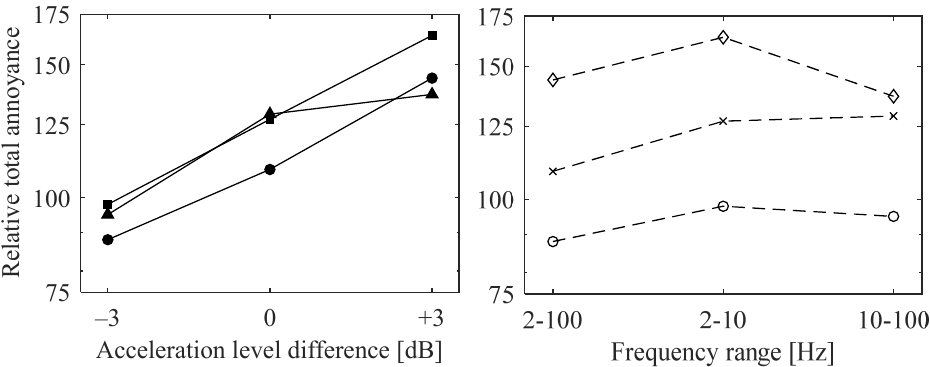
Figure 8. Interaction diagrams of the refuse collection vehicle scene (acceleration level, vibration frequency range); figure on the left: frequency range ● —2–100 Hz ■ —2–10 Hz ▲ —10–100 Hz vs. acceleration level difference; figure on the right: acceleration level difference ○ — − 3 dB x—0 dB ◊ —+3 dB vs. frequency range; N = 12.